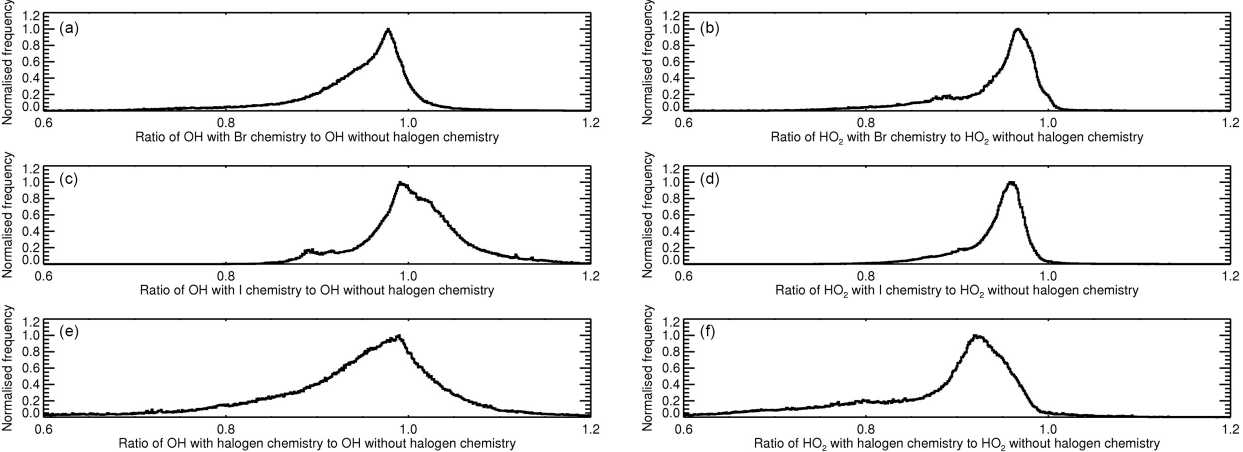
Figure 7. Normalised probability distribution functions showing the fractional changes in OH (a,c,e) and HO 2 (b,d,f) in GEOS-Chem for all grid boxes on inclusion of bromine chemistry (a,b) , iodine chemistry (c,d) and bromine and iodine chemistry combined (e,f) .